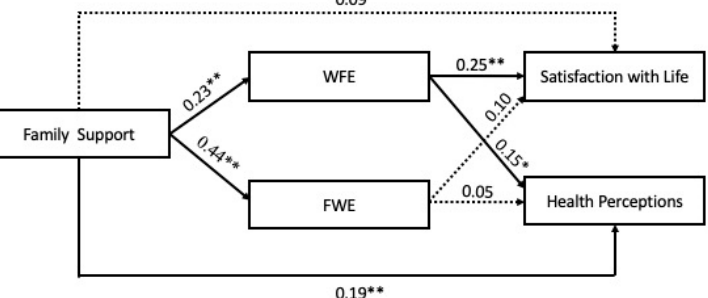
Figure 1. Standardized estimates for the partially-mediated model. ** p < 0.01; * p < 0.05.